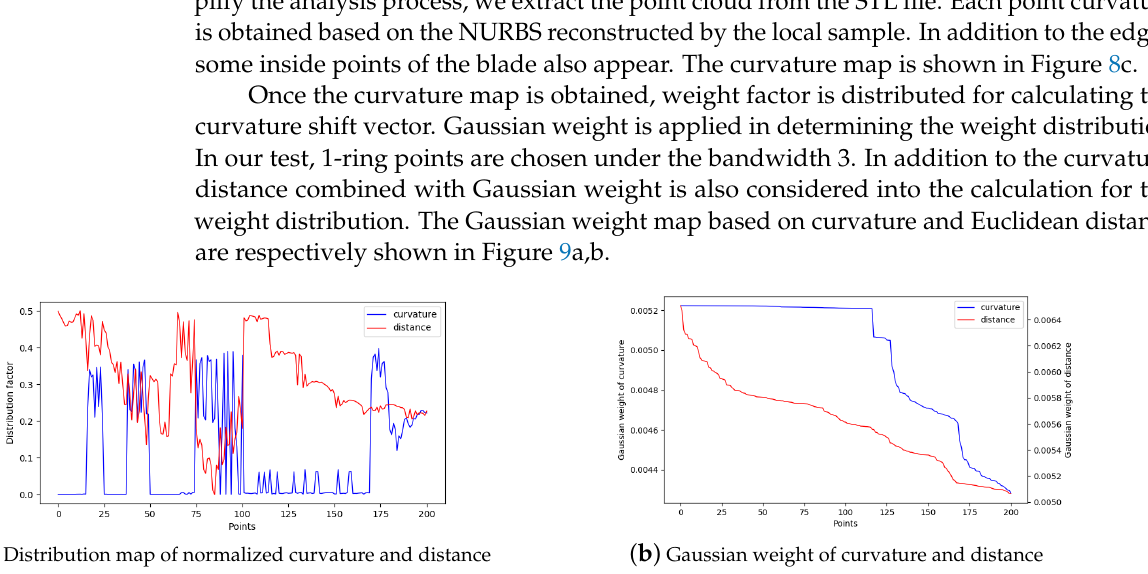
Figure 9. Gaussian weight map based on curvature and Euclidean